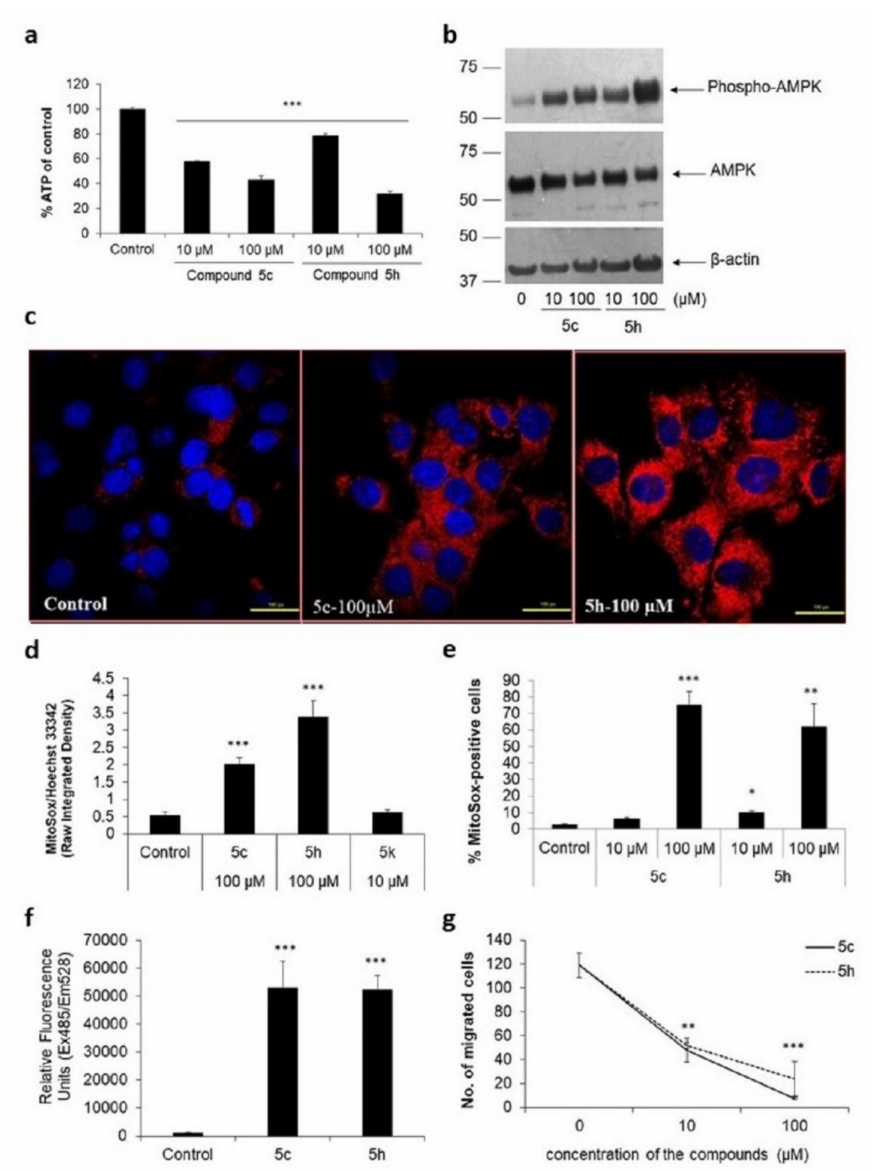
Figure 4. Compounds 5c and 5h mediate oxidative stress. ( a ) IMR-32 cells were stimulated with different concentrations of compounds 5c and 5h for 24 h in a 96-well format. Media were then removed and total ATP levels in each well were then measured using a bioluminescent kit. The relative luminescent units of untreated cells were considered to have a value of 100% to which stimulated cells were compared. *** p < 0.001 with respect to control cells. Error bars represent SEM, n = 3. ( b ) IMR-32 cells were stimulated with different doses of compounds 5c and 5h in a 6-well format, and total cell lysates were prepared after 24 h as described in Methods. The lysates were analyzed through Western blotting to show increased levels of phosphorylated AMPK protein. ( c ) IMR-32 cells were plated on coverslips and stimulated with 100 µ M compounds 5c or 5h